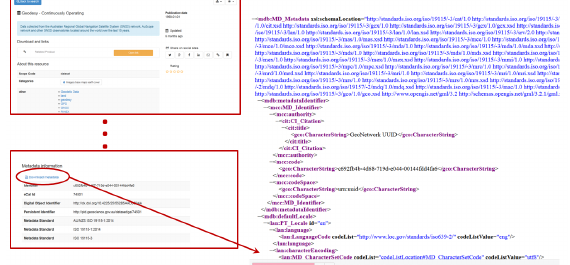
Figure 3 Missing identification of resources related to ‘Geodesy – Continuously Operating’ product.